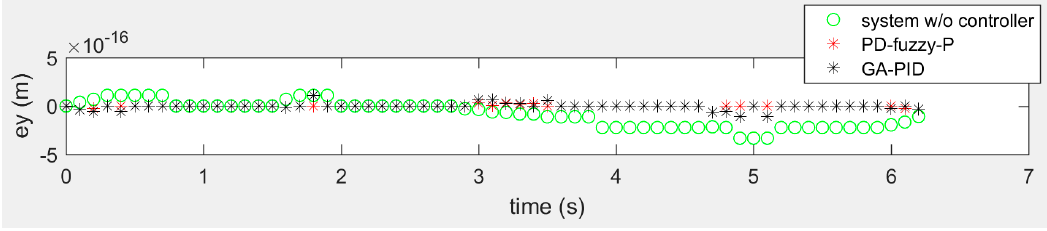
Figure 9. The error of the horizontal motion of the rose shaped path in the global frame in meter.